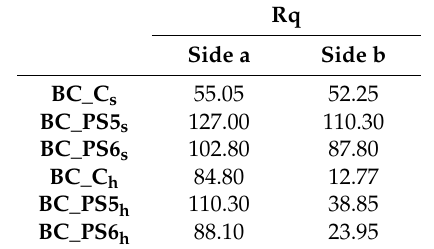
Rq Side a Rq Side a